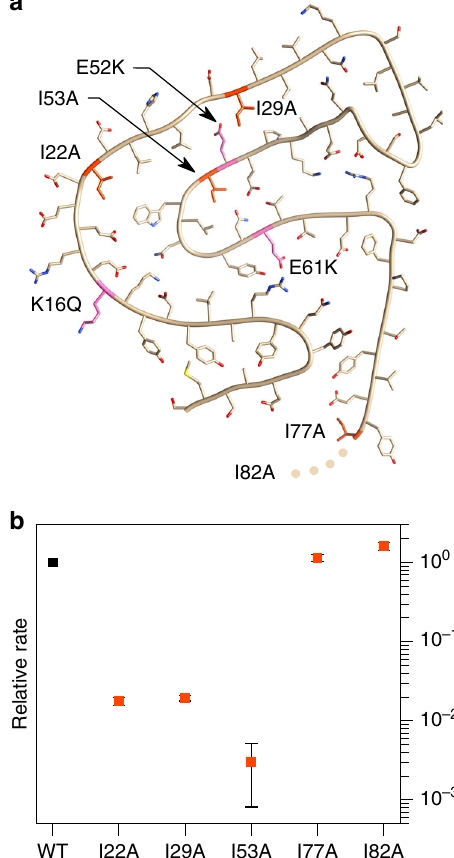
Fig. 6 Point mutations and their effect on fi bril elongation rates. a Top view of a PI3K-SH3 monomer derived from DF fi brils. Highlighted residues: Isoleucine residues mutated to alanine (I22A, I29A, I53A, I77A, I82A), from this work (red) and charged residues mutated by Buell et al. 47 (K16Q, E52K, E61K, pink). Mutation I82A is missing in the model due to the fl exible C- terminus. b Elongation rate of Ile-to-Ala mutants. The elongation rates are normalised to a WT rate of one. Source data are provided as a Source Data fi